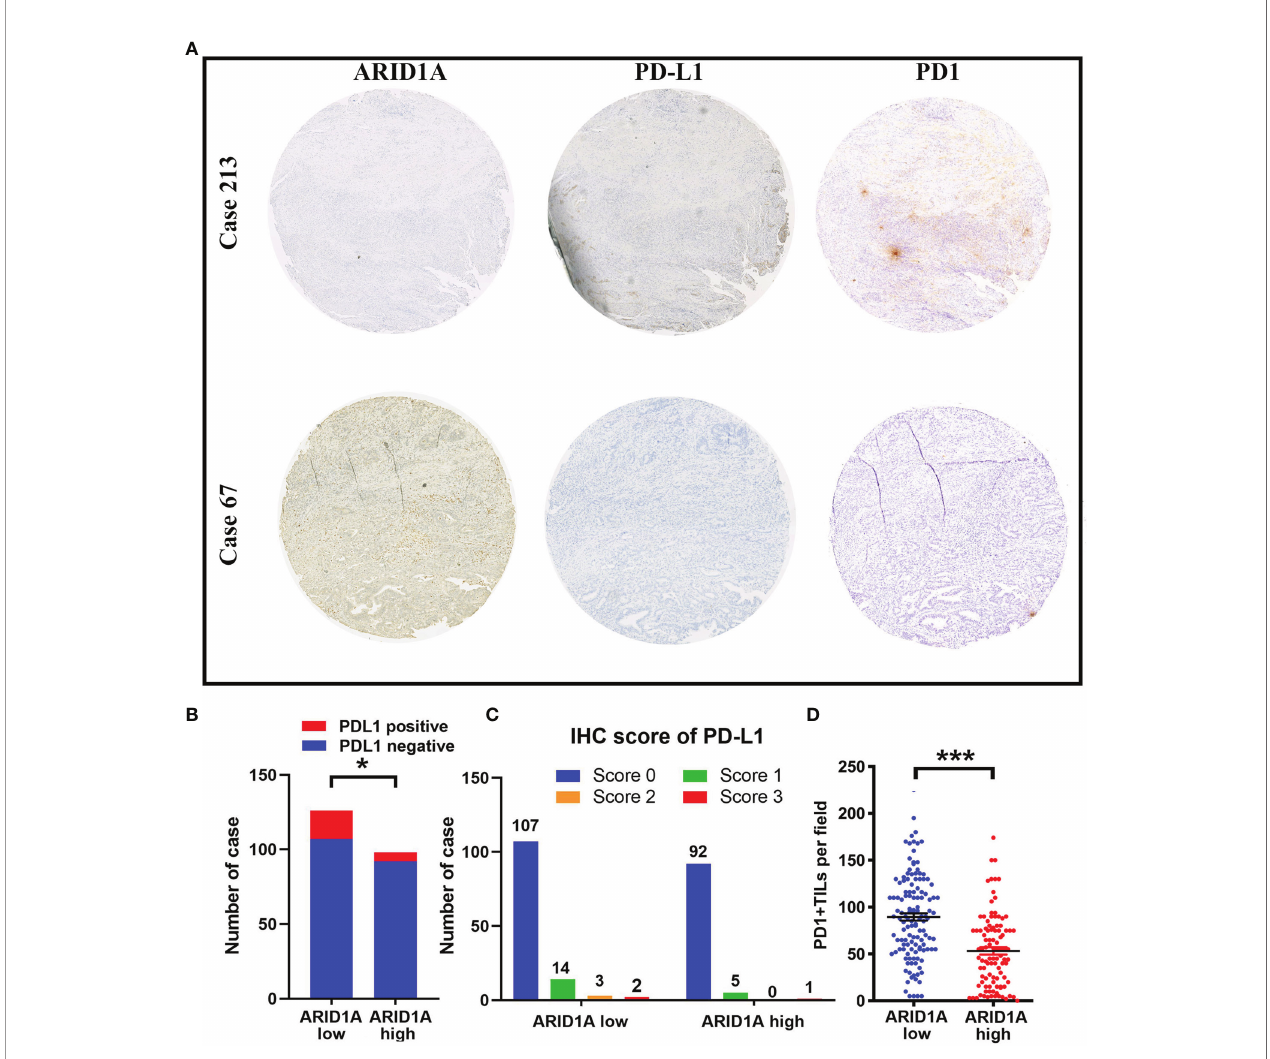
FIGURE 3 | The correlation of AT-rich interactive domain 1A (ARID1A) expression with PD-L1 expression and PD1+ tumor-in fi ltrating lymphocyte (TIL) counts in patients with gallbladder cancer (GBC). (A) Representative immunohistochemical images of PD-L1 expression and PD1+ TILs in patients with low (left upper) or high (left lower) ARID1A expression. (B) Distribution of PD1+ TILs in different ARID1A expression groups. (C) Proportion of patients with positive PD-L1 staining. (D) Distribution of the immunohistochemistry (IHC) score for PD-L1 in the ARID1A-high and ARID1A-low groups. *P < 0.05; ***P <